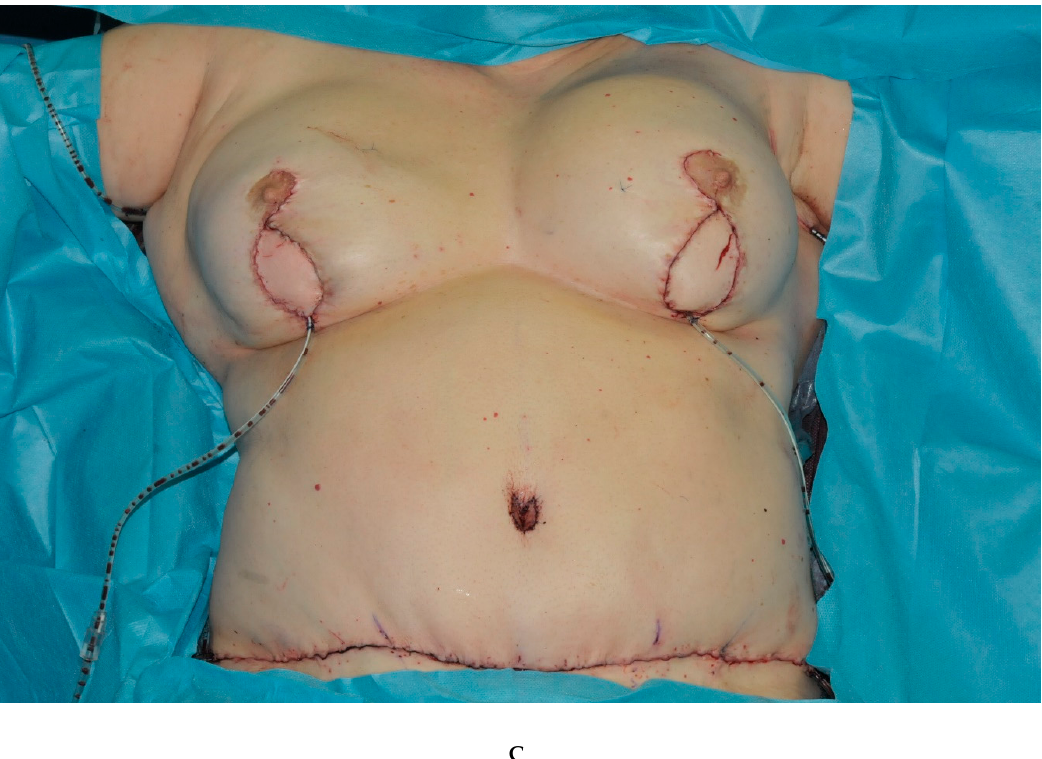
Figure 2. ( A ). Bilateral simultaneous breast reconstruction with DIEP flaps. ( B ). Raised bilateral DIEP flaps. ( C ). Intraoperative result after breast reconstruction with simultaneous bilateral double DIEP flaps.